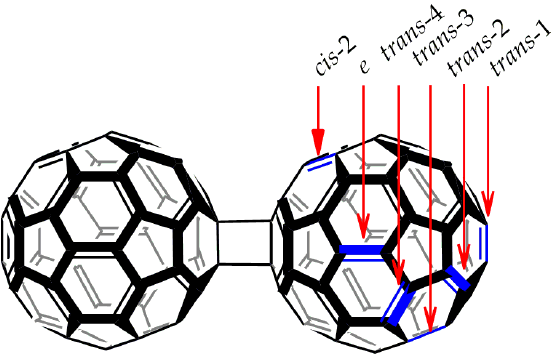
Figure 1. The formula of a [2+2] fullerene dimer (C 60 ) 2 . The 6.6 bonds, which are able to be connected to the other C 60 core, are shown with arrows. Their designation corresponds to the conventional nomenclature of the C 60 bisadducts [23]. Table 1. The TPSS/TZVP-calculated polarizability and structural parameters of (C 60 ) 2 and (C 60 ) 3 .